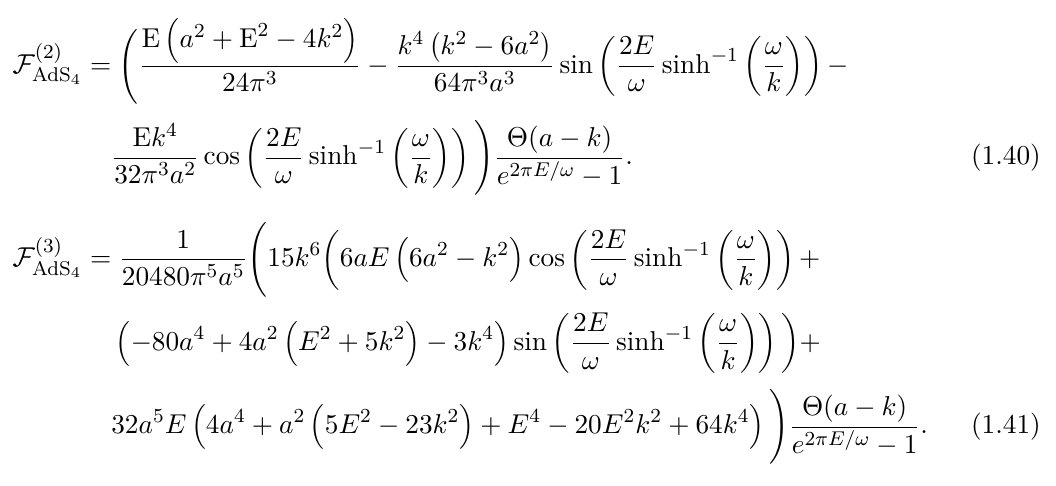
Also looking into n = 2 , 3 in four